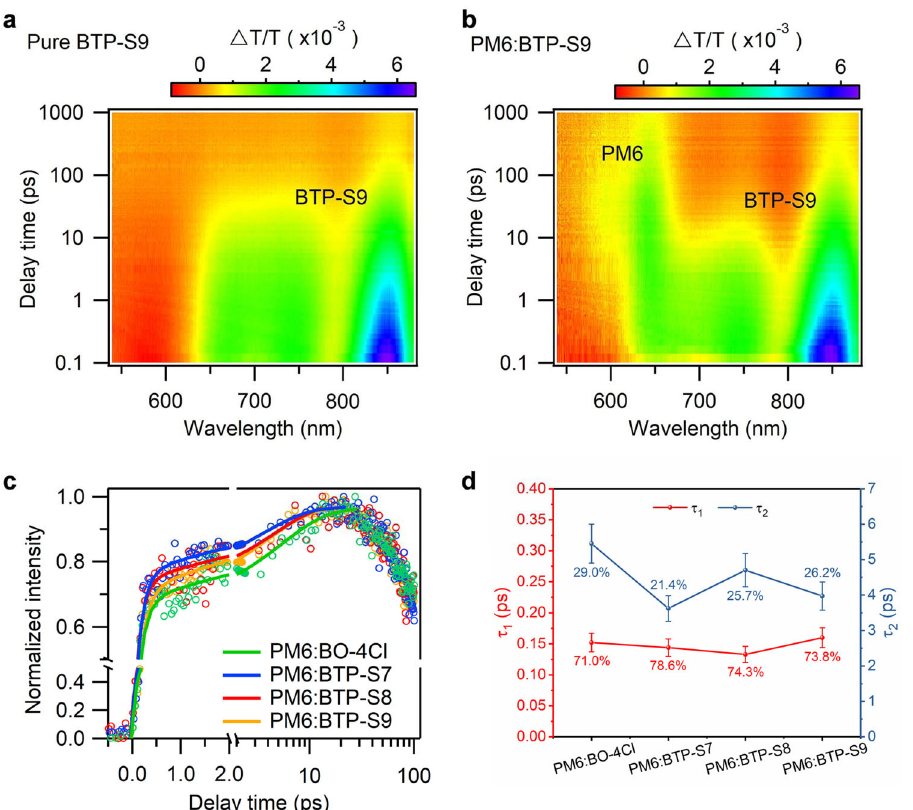
Fig. 5 Hole transfer dynamics. Color plot of TA spectra of a neat BTP-S9 fi lm and b PM6:BTP-S9 blend fi lm under 750 nm excitation. c Hole transfer kinetics in four blend fi lms. d Comparisons of τ 1 and τ 2 of different